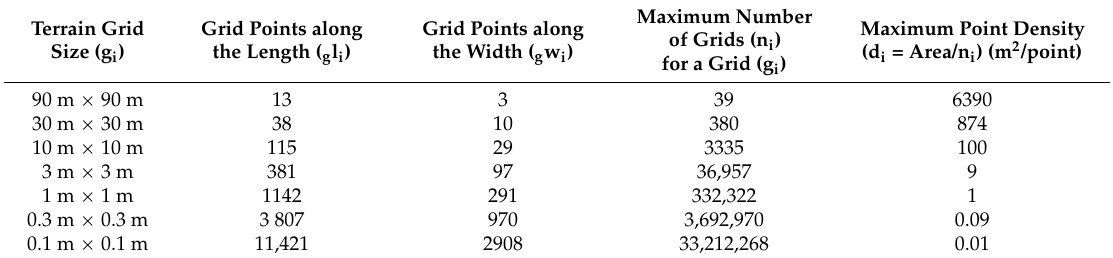
Table 3. Size and distribution of DEM point densities for the study area.